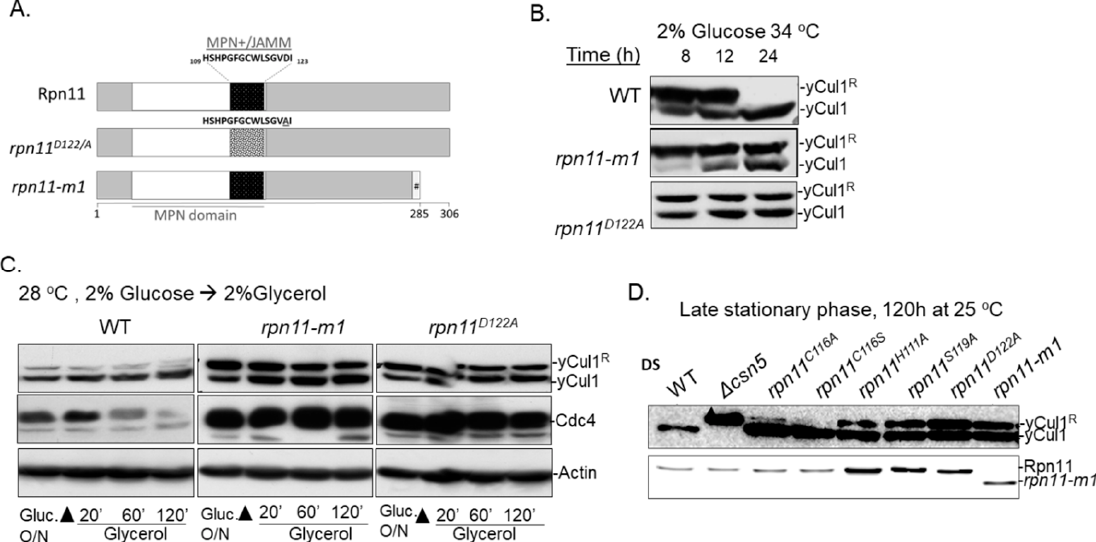
Figure 1. Distinct rpn11 mutants exhibit high yCul1 NEDDylation status at the post diauxic phase. ( A ) Schematic representation of WT (wild type) Rpn11 and the distinct mutants of rpn11-m1 and rpn11 D122 / A . WT Rpn11 includes 306 amino acids and bears an MPN domain at the amino terminal domain (white) with an MPN + –JAMM motif (black). This motif is mutated in rpn11 D122 / A , leading to defects in metalloprotease activity (dotted square). The mutant of rpn11-m1 is shorter due to a frameshift, causing the absence of 31 carboxyl terminal amino acids and their replacement by nine other amino acids. ( B ) WT and mutated Rpn11 ( rpn11-m1 and rpn11 D122 / A ) cells at the post-diauxic phase were diluted in YPD (yeast extract, peptone, dextrose) to 0.5 OD 600 and grown at 34 ◦ C. The modification status of yCul1 was examined by immunoblotting at indicated time points. Note: DS—diauxic shift. ( C ) WT and rpn11 mutants ( rpn11-m1 and rpn11 D122 / A ) at the post-diauxic phase were pre-washed and diluted to 0.5OD 600 in YPG (yeast extract, peptone, glycerol). The modification status of yCul1 was examined by immunoblotting at indicated time points. ( D ) Overnight-grown WT, ∆ csn5 , and various mutants of Rpn11 with a silent mutation ( rpn11 C116A , rpn11 C116S ) or active site dead mutation ( rpn11 S119A , rpn11 D122A ) were diluted to 0.5OD 600 and grown in YPD at 25 ◦ C for 120 h before examination of yCul1 modification status by immunoblotting. Notably, a permissive temperature of 25 ◦ C was used for